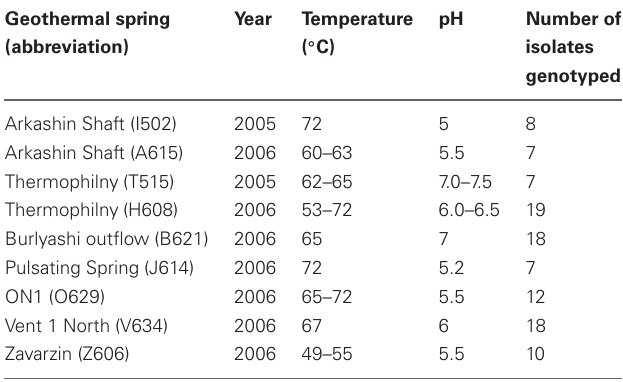
Table 1 | Geothermal springs of the Uzon Caldera from which T. uzonensis strains were isolated.